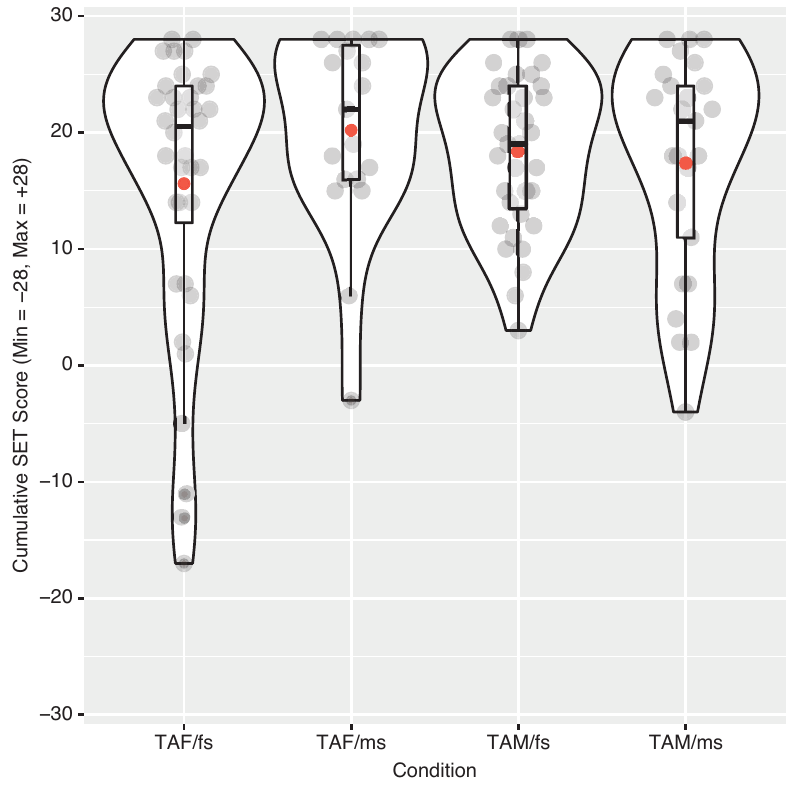
Figure 2. The violin plots of Khazan et al.’s recovered cumulative SET scores. The shape of violins matches closely the violins in Khazan et al.’s Figure 1. For each condition, violins also show individual data points, the mean of all data points (red dot), and the boxplot identifying outliers, that is, the values more than 1.5 inter-quartile range from the quartiles (edges of the